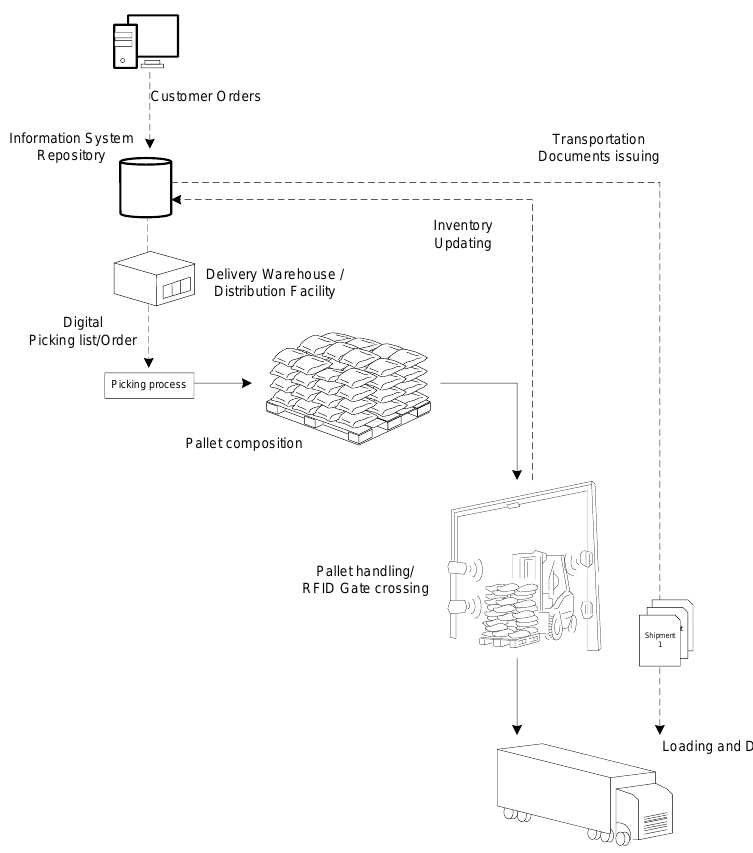
Figure 4. Shipping warehouse operations.